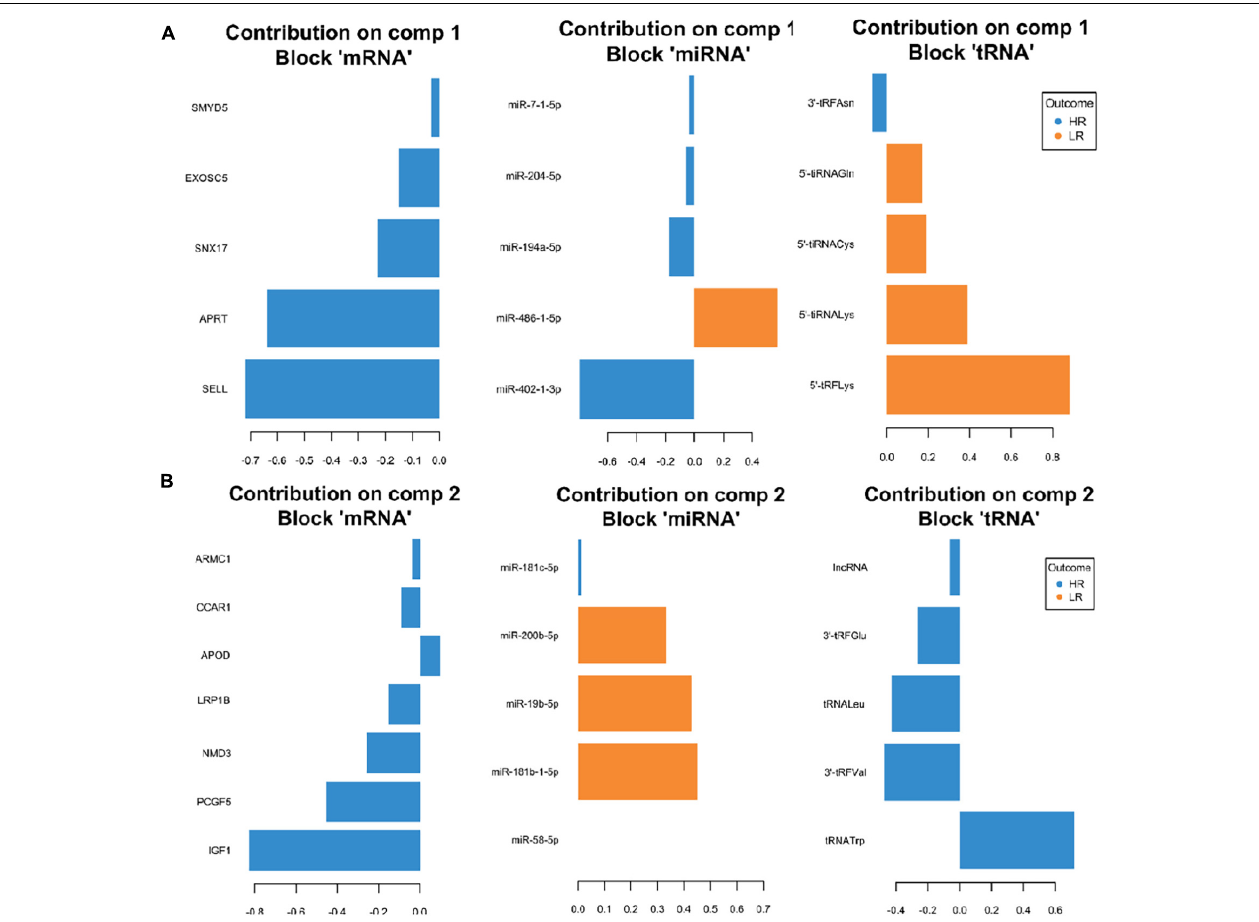
FIGURE 3 | Representation of the optimal biomarker panel of mRNA, miRNA and tRNA correlated to coping behavior haplotype groups over two component sets in the amygdala. DIABLO minimal set of feature selection across data types could discriminate between high-reactive (HR) and low-reactive (LR) groups in component 1 (A) and component 2 (B) . Blue-colored bars are indicators for the HR group, yellow-colored bars indicate the LR group (DIABLO: Data Integration Analysis for Biomarker discovery using Latent